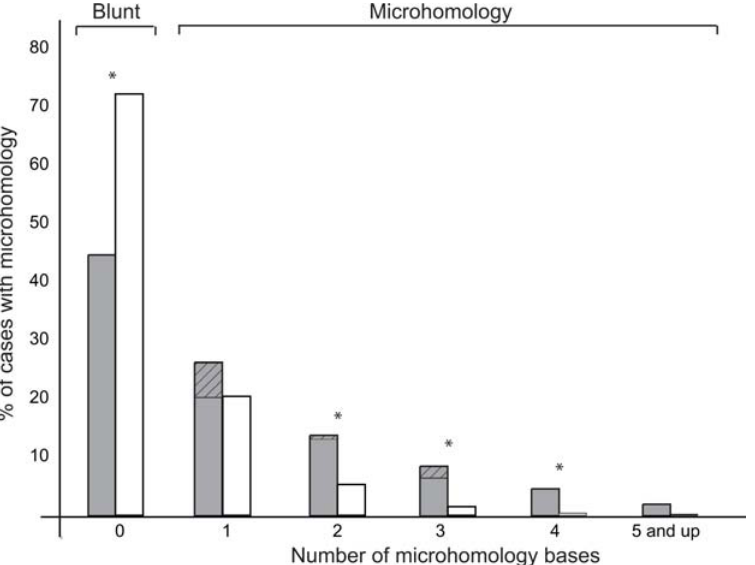
Figure 3. Statistical analysis of DSBR involving microhomologies. The percentages of numts (grey) and random (white) datasets with a specific microhomology length are shown. The numt dataset includes 152 genome- numt fusion points, and the random dataset includes 15,200 randomly chosen genome and mitochondrial positions. A one-tail Fisher exact test (presence/absence of microhomology, P =1.3 6 10 2 12 ) was statistically significant. A star indicates a significant difference between numt and random datasets for a given microhomology length (binomial test, P , 0.05/6). The percentage of imperfect microhomology is shown at the top of the graph with a diagonal pattern. Imperfect microhomology was higher in the numt dataset than in the random dataset (Fisher exact test, all P =0.01, microhomology of 1, P